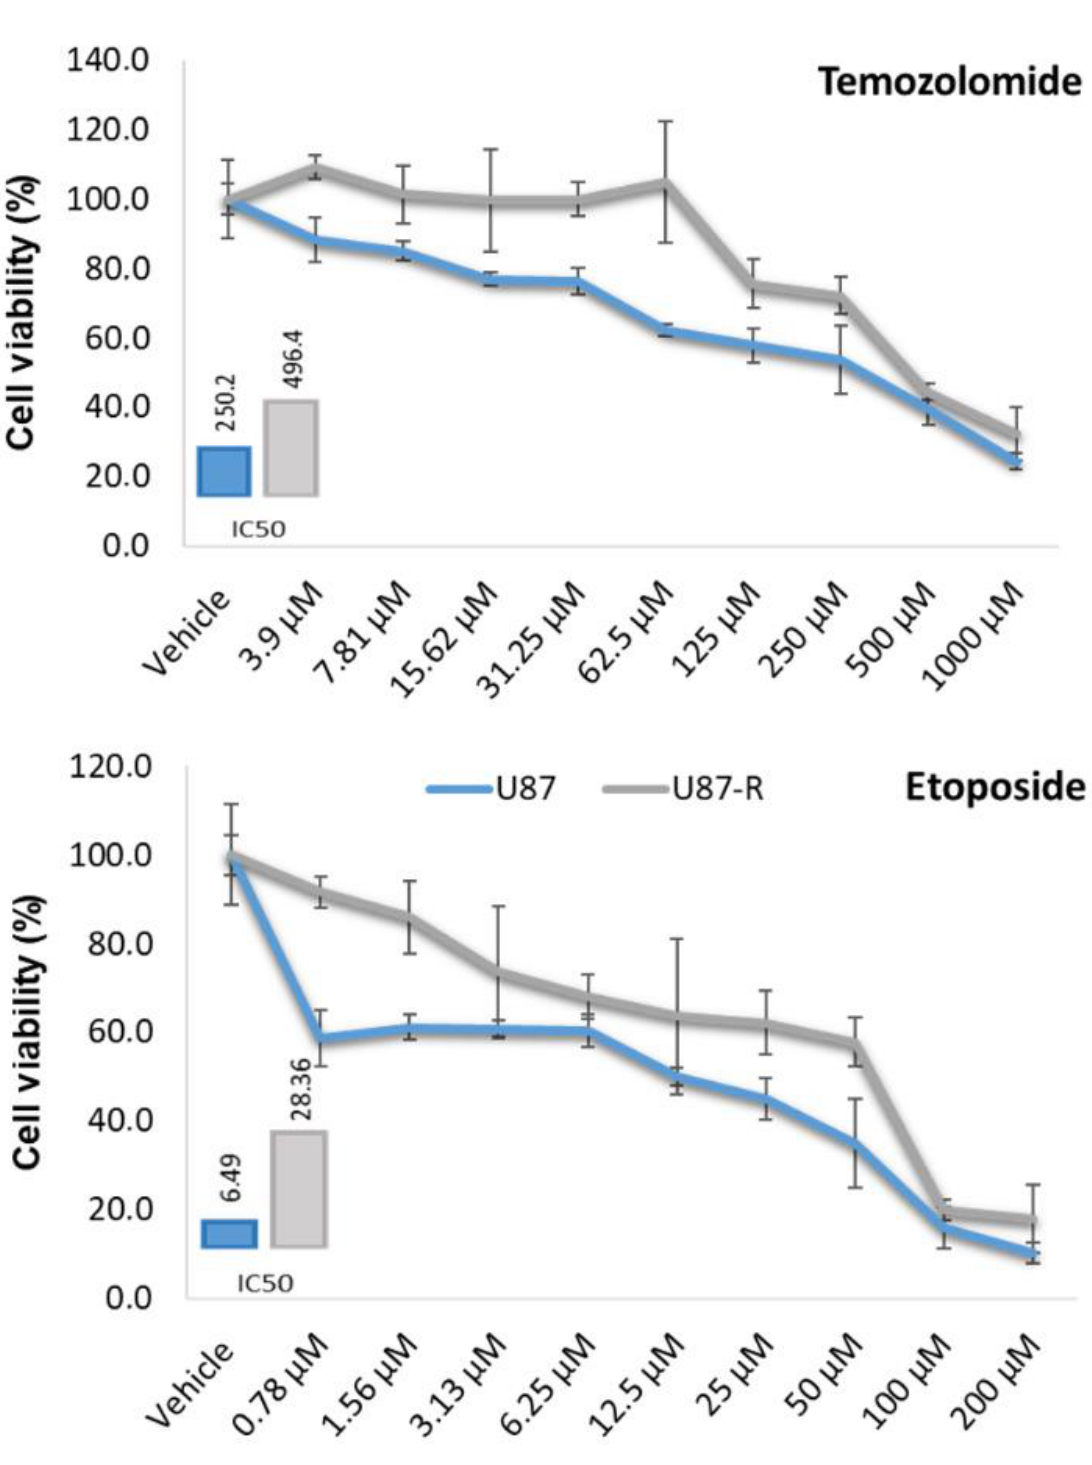
Figure 3. Cell viability (%) in resistant U87-R and normal U87 cell populations treated with nine different doses of temozolomide and etoposide for 72 h. MTT data were used to calculate IC the probit analysis function of SPSS20. All percentages are given as mean ± SD, n =